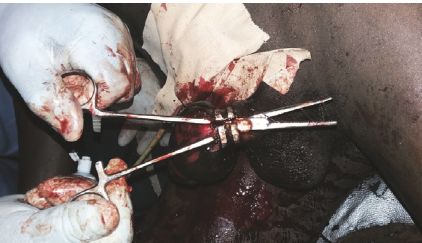
Figure 4: Artery Forceps insinuated between the penis and the ring to minimize risk of penile damage while cutting the ring.